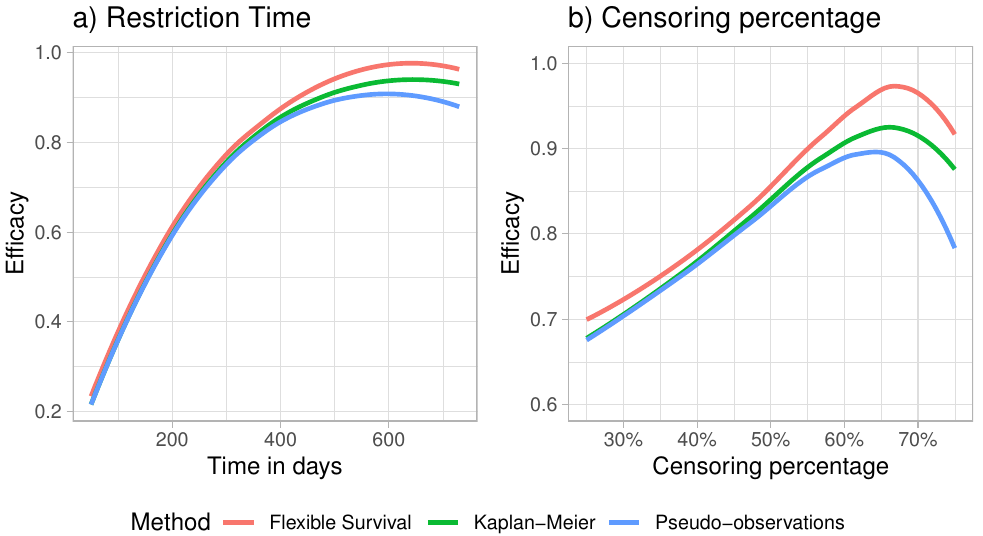
Figure 1. The effect of restriction time ( a ) and censoring percentage ( b ) on the efficacy of the three commonly used RMST estimation